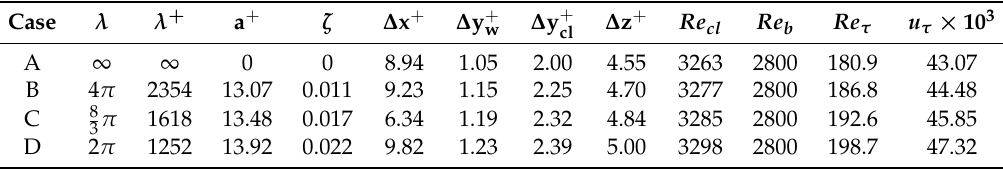
Table 1. Tabulation of different design parameters for the simulations such as: wavelength ( λ ), amplitude ( a ), and steepness ( ζ = 2 a ) of the wavy surface, friction velocity ( u τ ), Reynolds numbers ( Re ) λ based on boundary layer height ( δ ), and different velocities expressed as the subscripts (‘cl’ = centerline velocity; ‘b’ = bulk velocity; ‘ τ ’ = friction velocity) and the grid spacing in different directions (’ ∆ x ’ = streamwise; ‘ ∆ z ’ = spanwise; ‘ ∆ y w ’ = wall normal near the wall; ‘ ∆ y cl ’ = wall normal near the flow centerline). Superscript ‘+’ refers to inner scaled quantity (scaled with respect to dynamic viscosity ( ν ) and friction velocity ( u τ